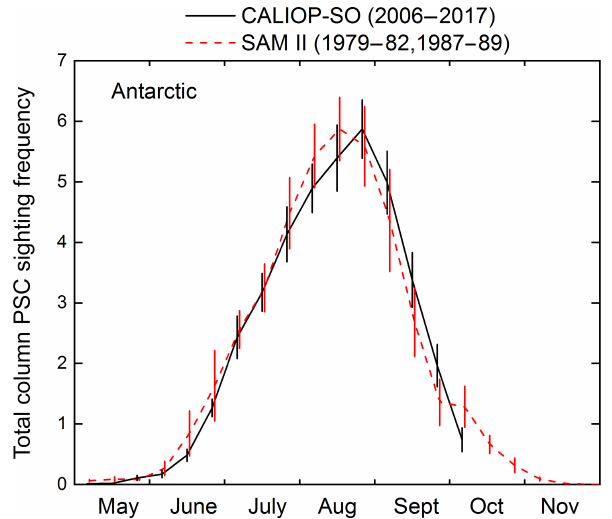
Figure 29. Multi-year mean Antarctic PSC column occurrence fre- quency from May to November for CALIOP-SO (black solid) and SAM II (red dashed), along with standard errors in the means.